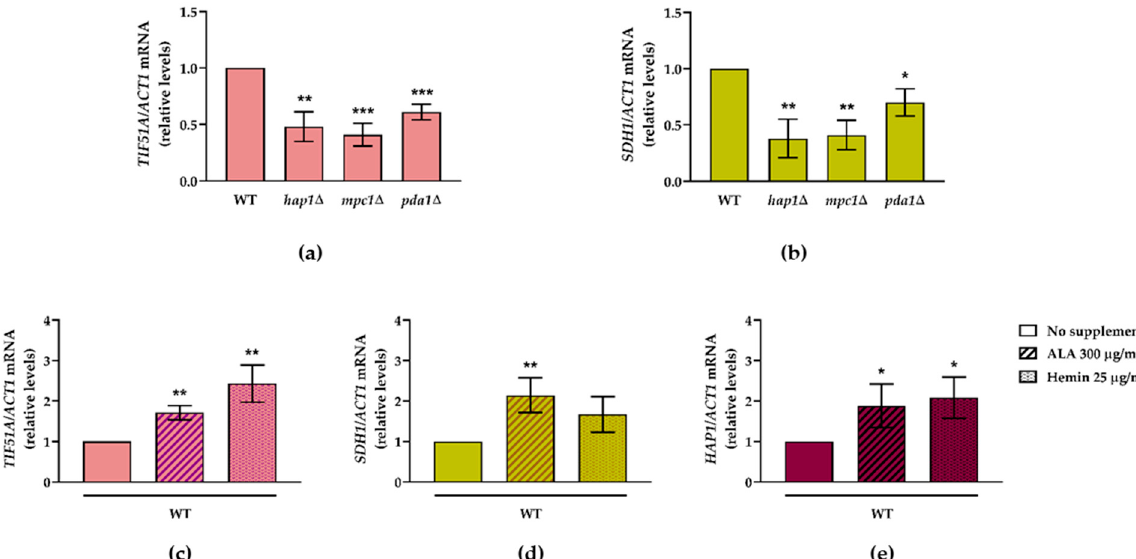
Figure 5. eIF5A expression is regulated by the metabolic flux into the TCA cycle and heme cellular levels. ( a , b ) The WT, hap1 ∆ , mpc1 ∆ and pda1 ∆ strains were grown in YPGal medium for 24 h. The relative TIF51A ( a ) and SDH1 ( b ) mRNA levels were determined. The results are expressed in relation to the WT value. ( c – e ) The WT cells were grown in YPD medium with or without the addition of ALA (300 µg/mL) or hemin (25 µg/mL) for 24 h. The relative TIF51A ( c ), SDH1 ( d ) and HAP1 ( e ) mRNA levels were determined. The results are expressed in relation to the value for the no supplement condi- tion. ( a – e ) and are shown as the means ± SD of three independent experiments. Statistical significance was measured by a Student’s t -test. * p < 0.05, ** p < 0.01, *** p < 0.001.